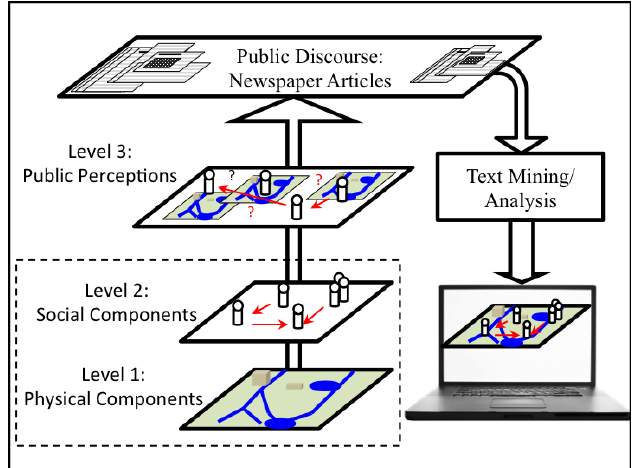
Figure 1. Schematic diagram illustrating how physical infrastructure, public perception, discourse and analysis are used as a framework for identifying the water management